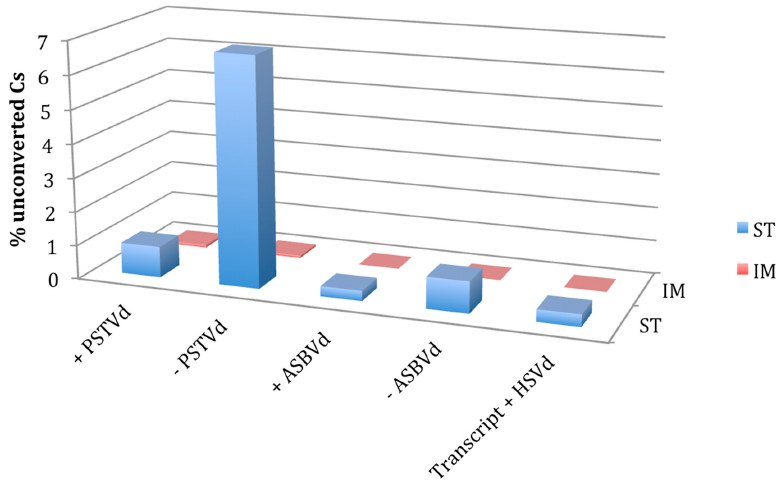
Figure 1. Comparison of RNA bisulfite sequencing by standard (St) and improved (Im) protocols. Percentage of unconverted cytosines detected in + and − strands of potato spindle tuber viroid (PSTVd) and avocado sunblotch viroid (ASBVd) infecting their natural hosts and in the in vitro transcript of the + strand of hop stunt viroid (HSVd) used as a negative control.